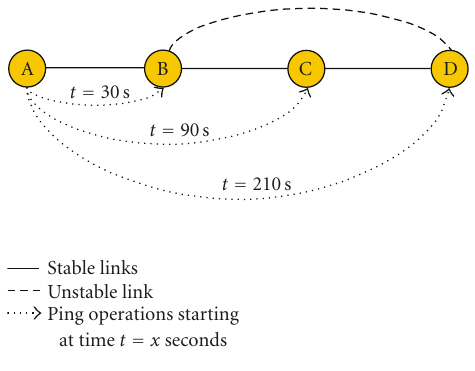
Figure 4: Ping operations on a string